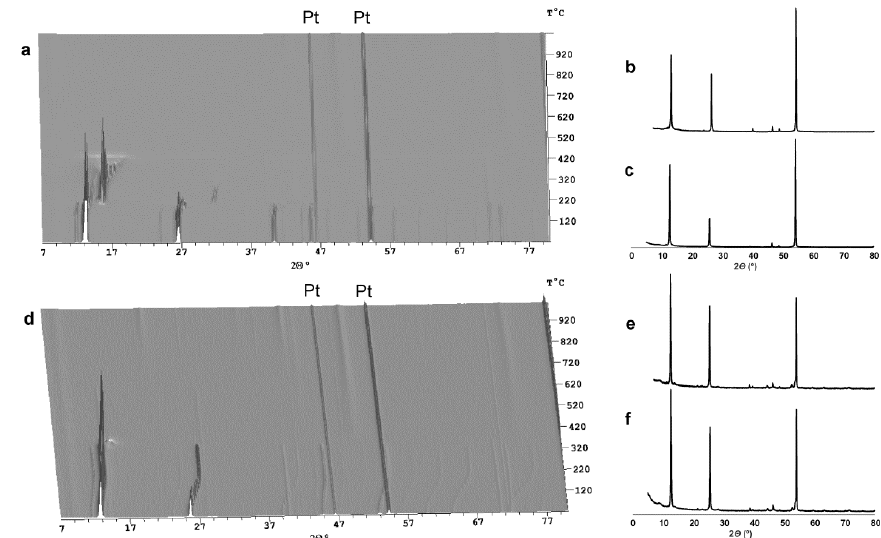
Figure 2. The powder X-ray diffraction patterns recorded for hydrotalcite in the temperature range 25– 1000 °C ( a ), before ( b ) and after annealing to 300 °C ( c ) and iowaite in the temperature range 25–1000 °C ( d ), before ( e ) and after annealing to 300 °C ( f ). Note: Pt indicates reflections from Pt sample